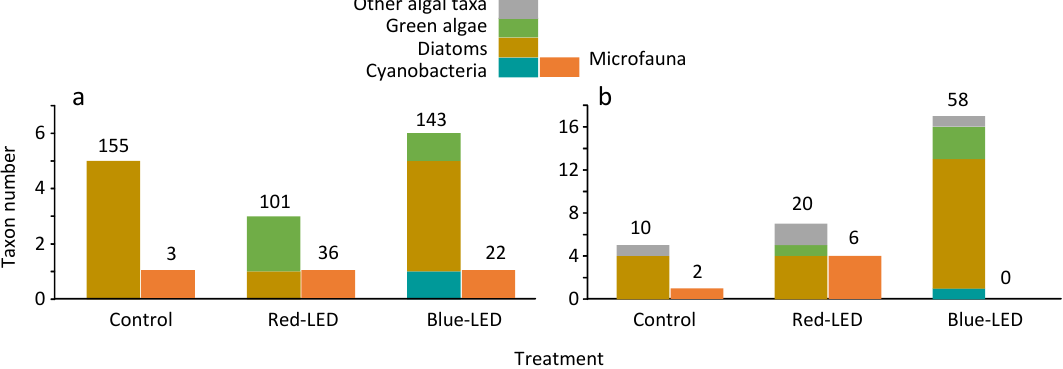
Figure 6. The number of taxa occurring in the periphyton community on the filament ( a ) and in the plankton community from the water ( b ) of the three depressions. The number on the bars shows the total cell abundance (( a ): cells mm −2 , ( b ): cells 0.1 mL −1 ).